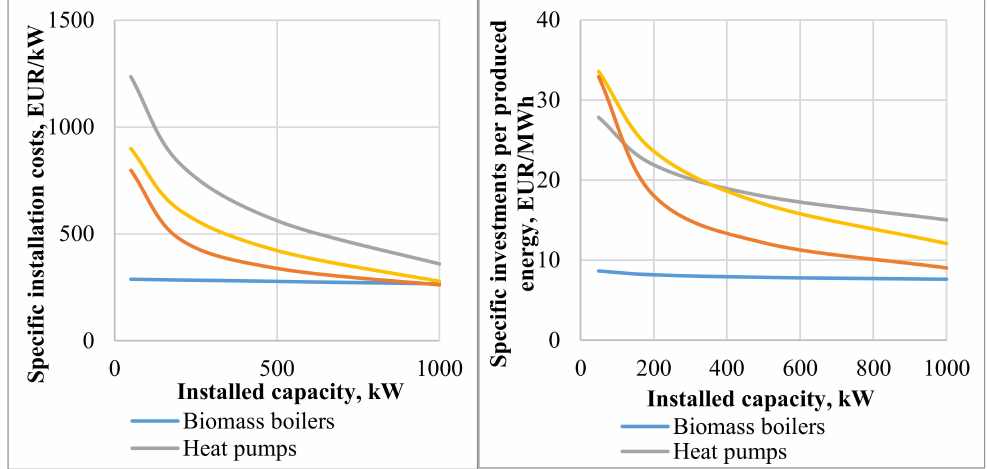
Figure 4. Estimated benchmarks for di ff erent RE technologies in individual